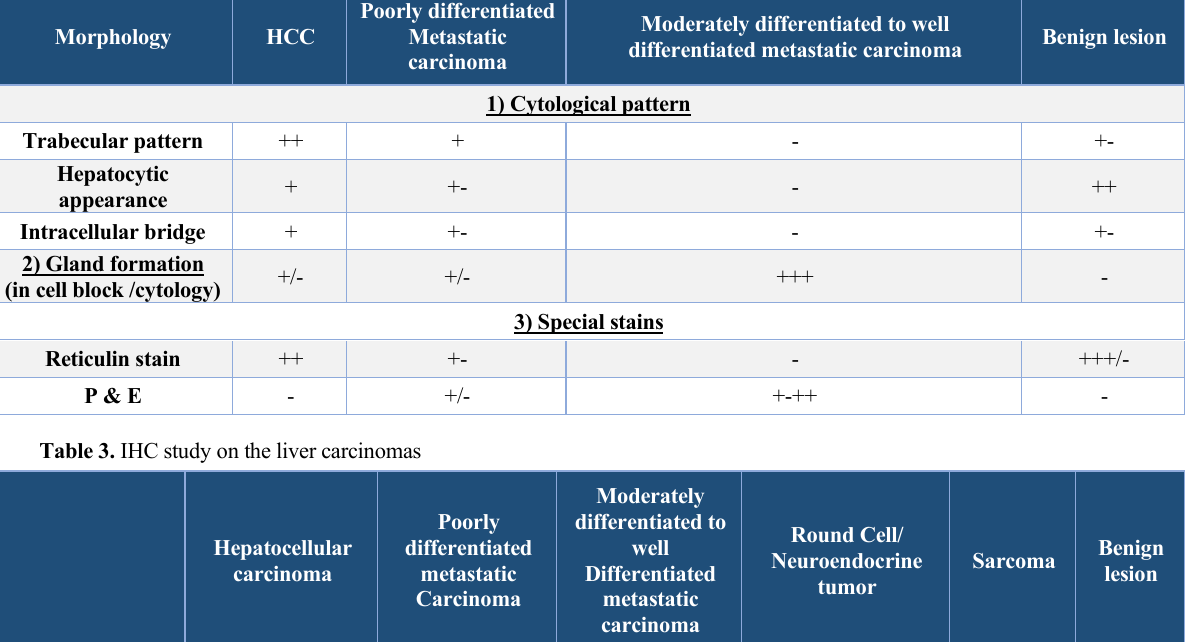
Table 2. Differentiation of the tumors based on morphology